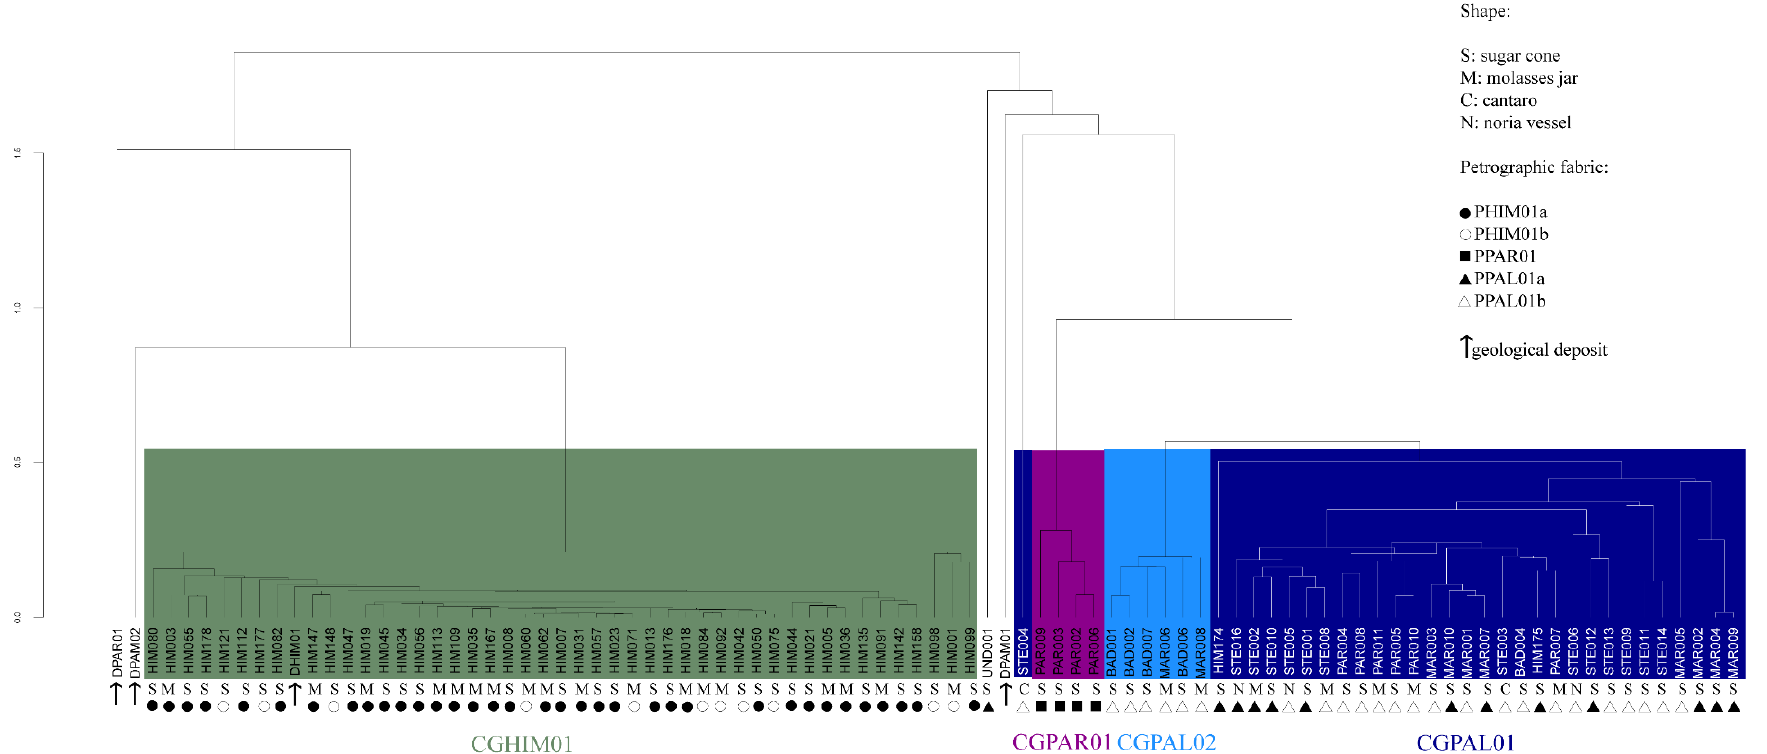
Figure 6. Dendrogram resulting from the analysis of the 92 individuals on the sub-composition Na 2 O, MgO, Al 2 O 3 , SiO 2 , K 2 O, CaO, TiO 2 , V, Cr, MnO, Fe 2 O 3 , Ni, Zn, Ga, Rb, Sr, Y, Zr, Nb, Ba Ce, and Th, clr transformed, using the square Euclidean distance and the centroid agglomerative algorithm.